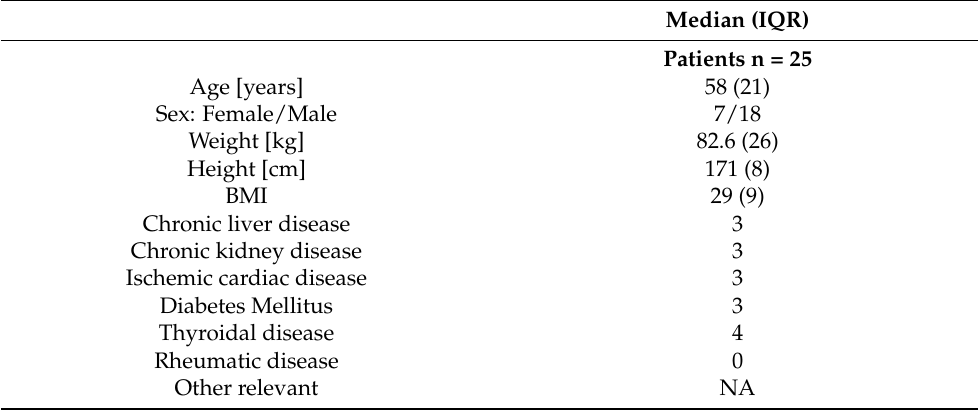
Table 3. Characteristics of patients enrolled in the study.